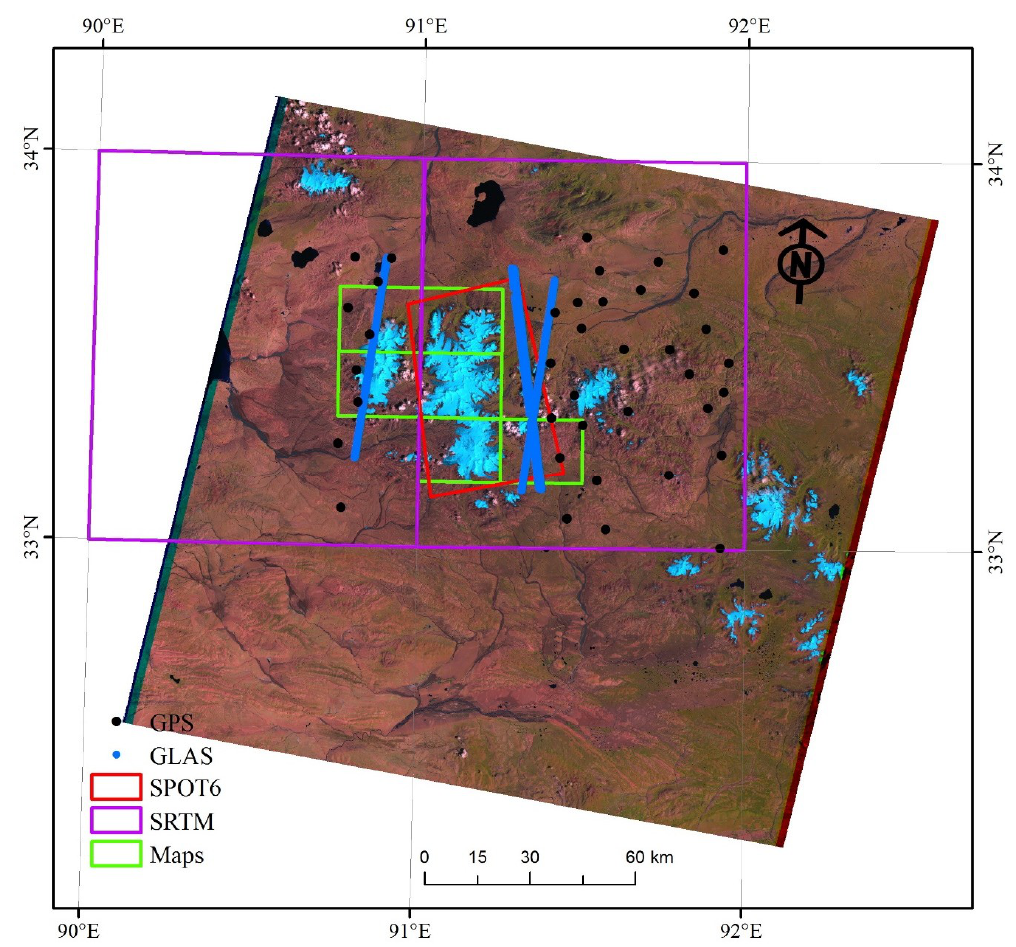
Figure 2. Digital elevation models (DEMs) data range in four phases and the distribution of Geoscience Laser Altimeter System (GLAS) and Global Positioning System (GPS) measuring points. Table 2. Comparison of DEM1968, SRTM, DEM2005 and DEM2013 with GPS and GLAS. GPS Points GLAS DEMs